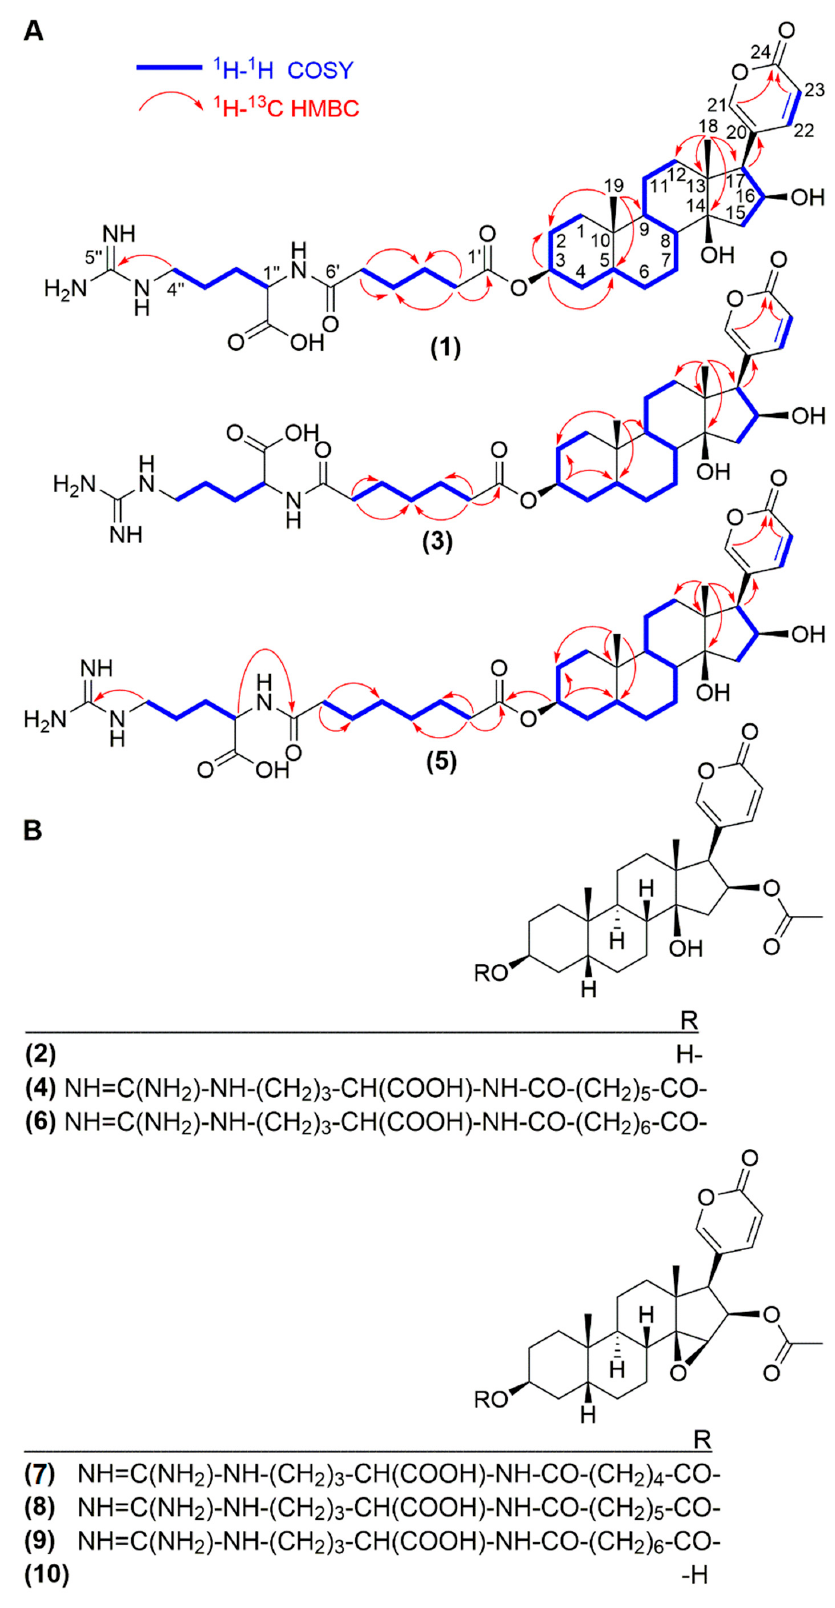
Figure 1. Structures of compounds 1 – 10 . ( A ) Selected HMBC and COSY correlations for compounds 1 , 3, and 5 . ( B ) Chemical structures of known bufadienolides.